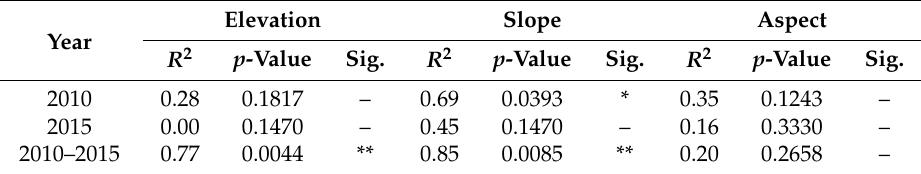
Figure 7. AGB/change within the stratified topography in Wuyi County: ( a ) AGB/change with elevation; ( b ) AGB/change with slope; ( c ) AGB/change with aspect; ( d ) radar chart of AGB/change with aspect. Table 4. Regression results between AGB/change and terrain features in Wuyi County.